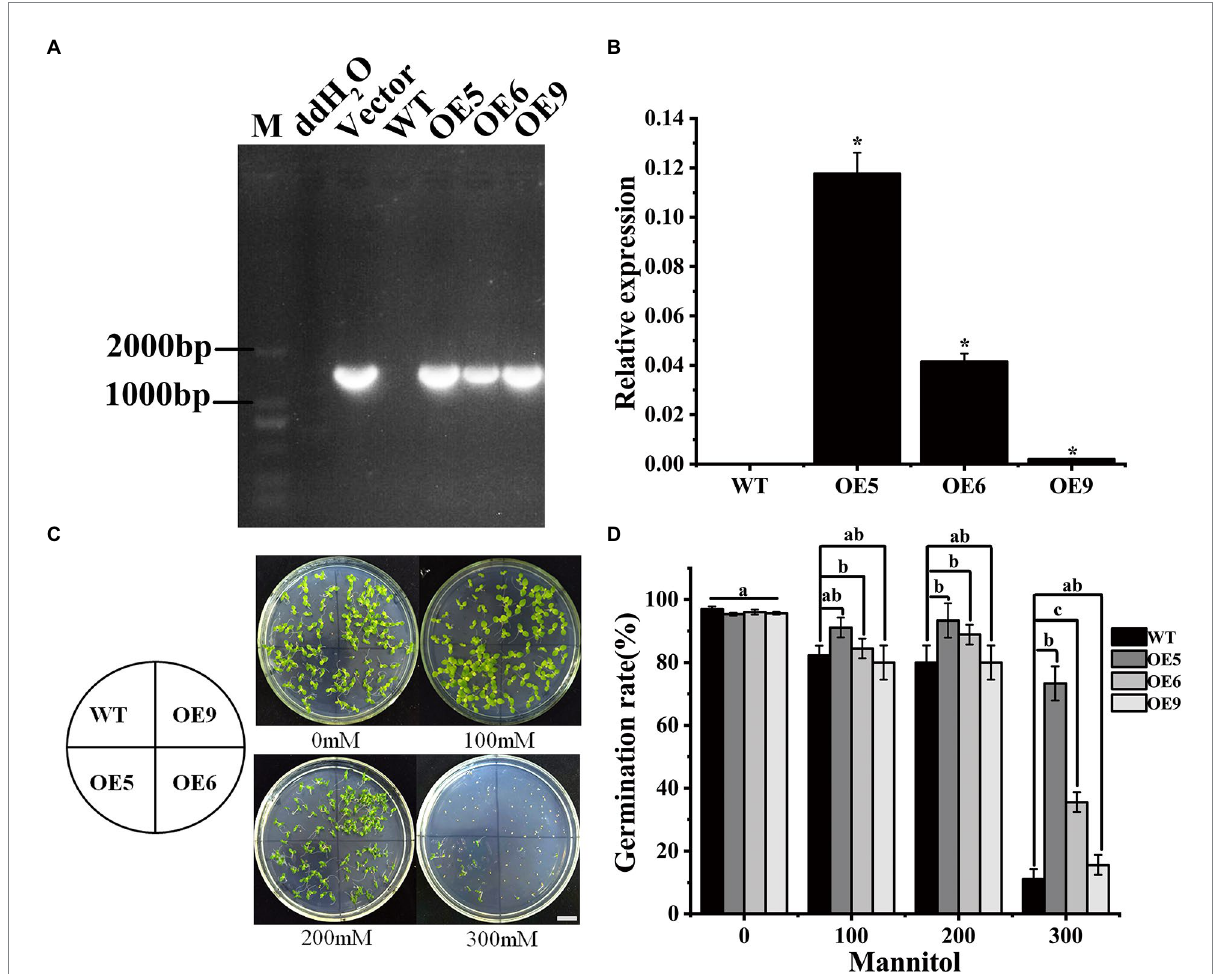
FIGURE 3 Genetic transformation of Chinese cherry CpCHS1 into tobacco. (A) PCR method to identify transgenic tobacco lines. (B) Detection of the expression level of CpCHS1 in tobacco. (C) Germination of WT and OE lines at different mannitol concentrations. (D) Statistics on the germination rate of tobacco seeds under different mannitol concentrations. Different letters and ‘*’ indicate the significant differences of the three replicates as determined by SPSS software ( p <